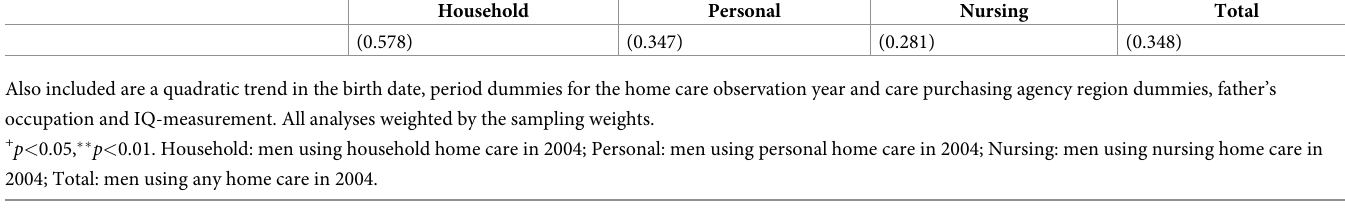
S2 Table. Odds ratios non-health controls on later life home care use. S3 Table. Parameters panel probit model with random effects, joint model: Parameters homecare use probability. S4 Table. Parameters panel probit model with random effects, joint model: Parameters probit survival